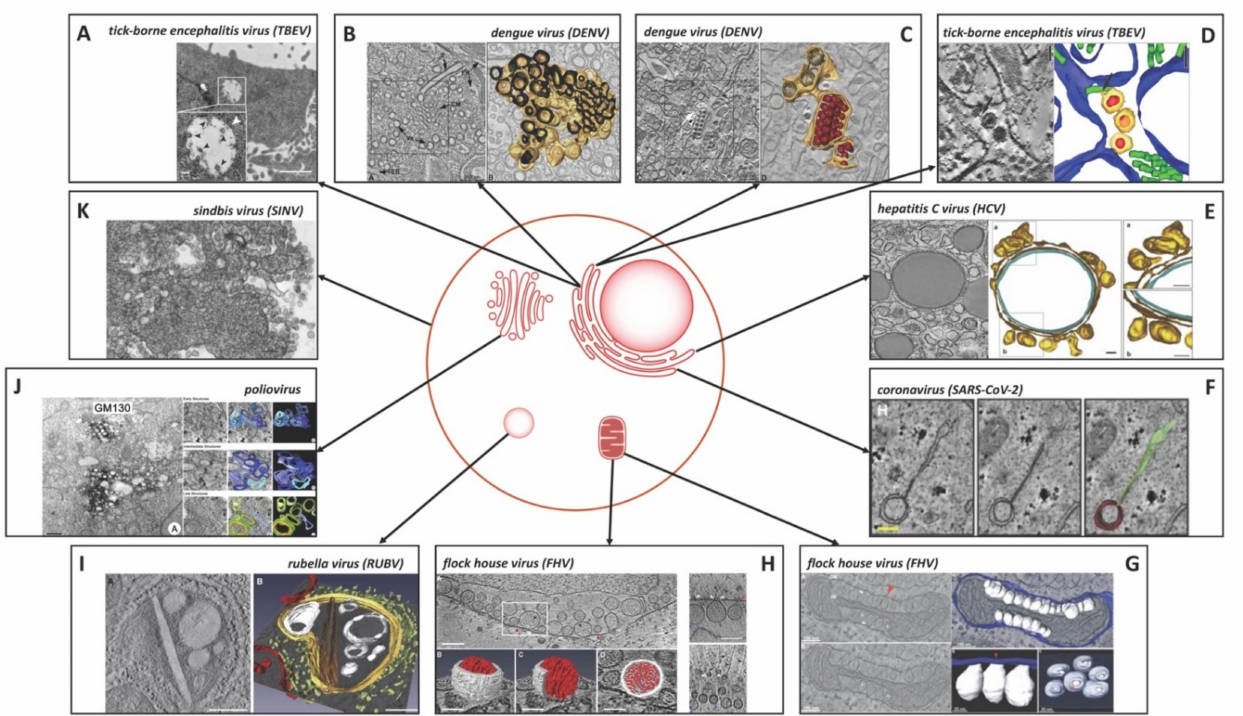
Figure 3. Structure and origin of animal positive-strand RNA virus replication organelles. ( A ) TEM images of HeLa cells transfected with the TBEV DNA replicon. White arrowheads show dilated ER areas; black arrowheads denote replication-vesicle-like structures inside the dilated ER areas. Insets show magnifications of the indicated areas. Scale bars 1 µ m [41]. ( B , C ) DENV-infected Huh7 cells. (left) Tomogram slice shows DENV-induced convoluted membranes